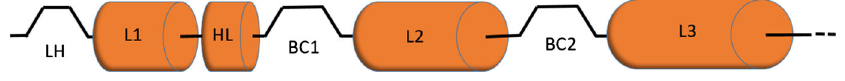
FIG. 1. A schematic of LCLS-II